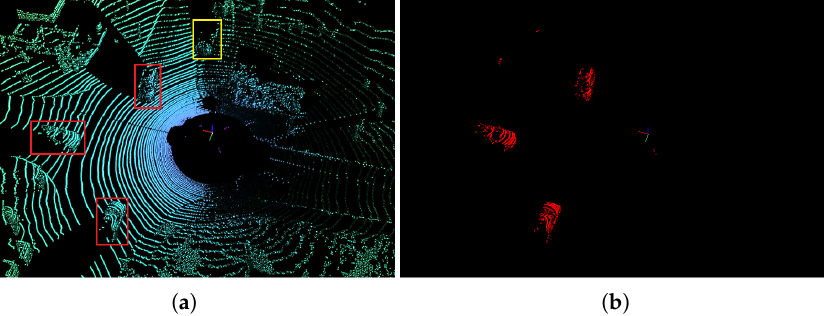
Figure 1. Moving object segmentation using our approach. ( a ) Raw Point Cloud ; ( b ) Segmented Point